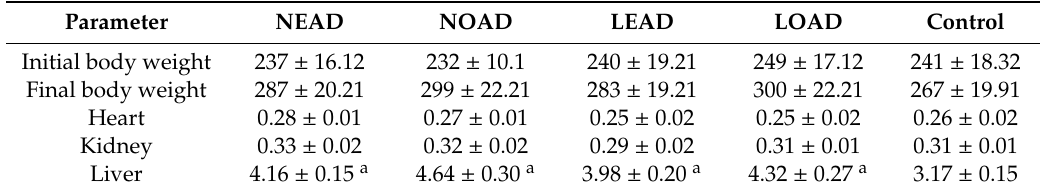
Table 7. Body weight and relative weight of the heart, kidney, and liver in the various groups over 60 days of